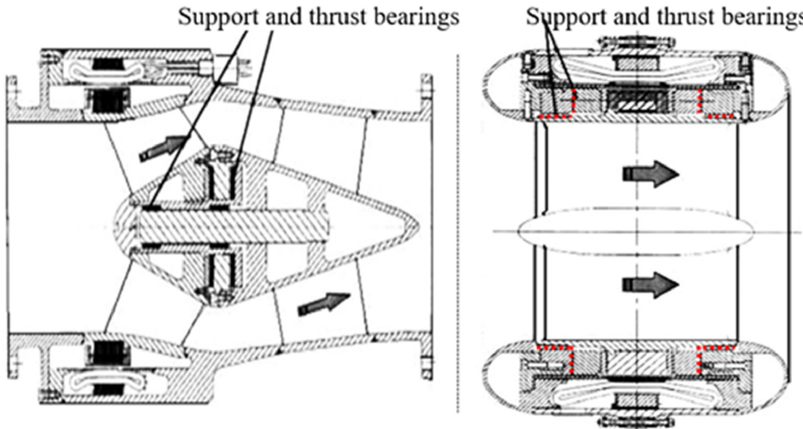
Figure 6. The location of the bearings in an IMP [10].